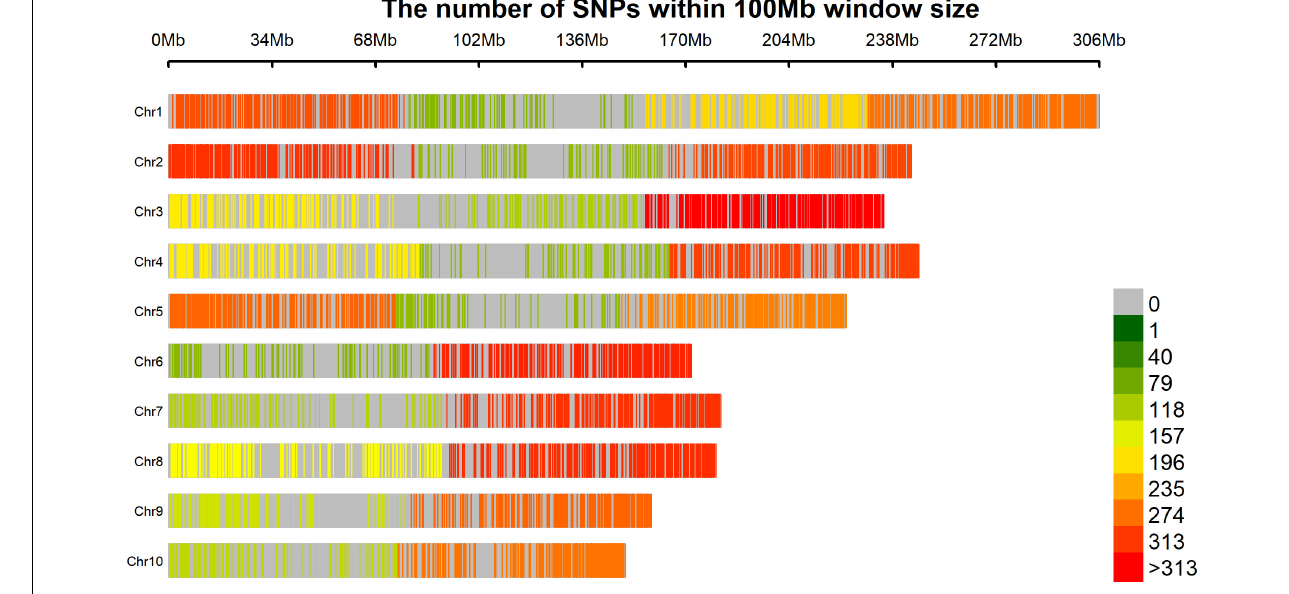
amplitude of the drought tolerance index was lower in